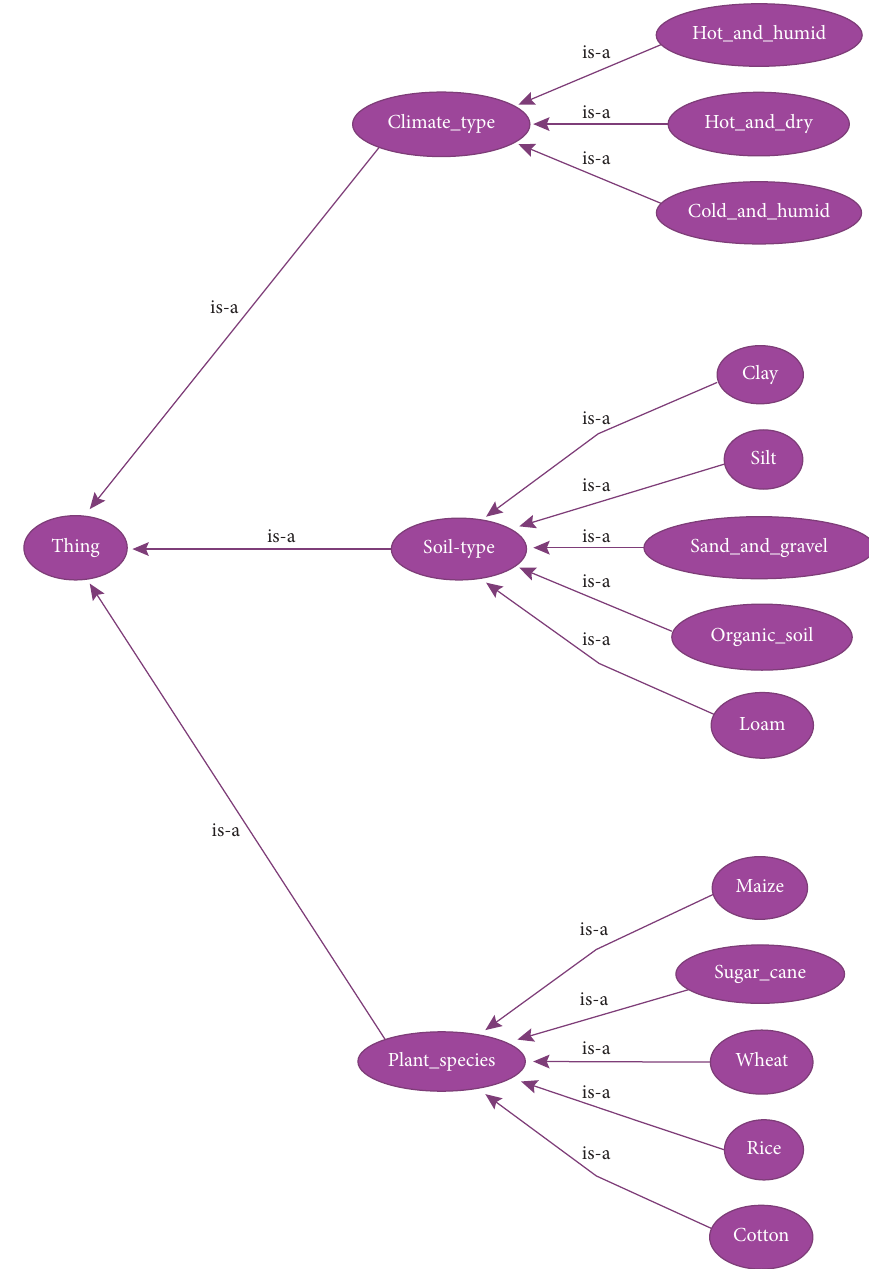
Figure 3: Ontology: an abstract